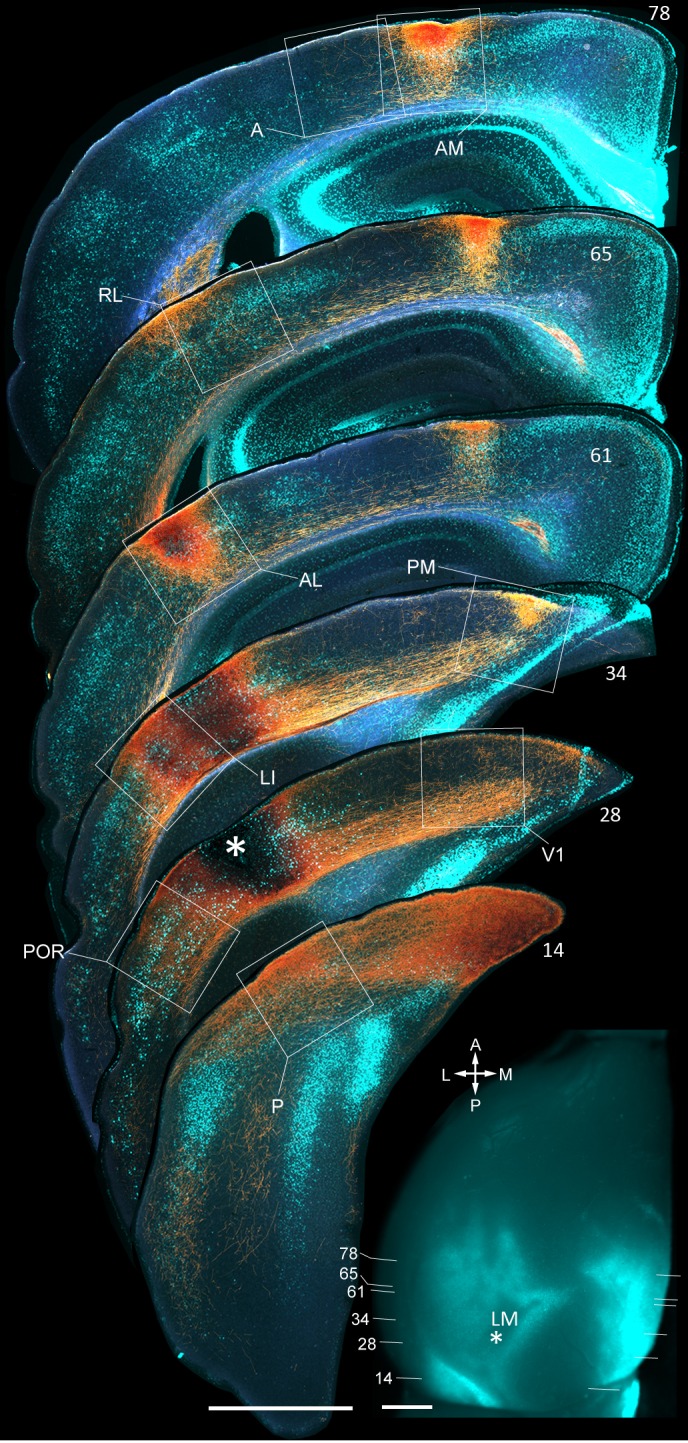
Coronal sections showing anterogradely labelled axons (yellow/orange) from LM to V1, LI, P, POR, AL, PM, RL, AM and A, upon BDA injection into LM.Calossally projecting neurons (light cyan) are labelled retrogradely after injection of bisbenzimide into the opposite hemisphere. Boxed regions show projections to each of the nine target areas. Asterisk in coronal section 28 denotes injection site in LM. Scale bar, 1 mm. In situ image of left hemisphere shows retrogradely bizbenzimide-labelled neurons marking callosal landmarks. Injection site in LM (asterisk) and numbers of coronal slices shown above are indicated. Scale bar, 1 mm.